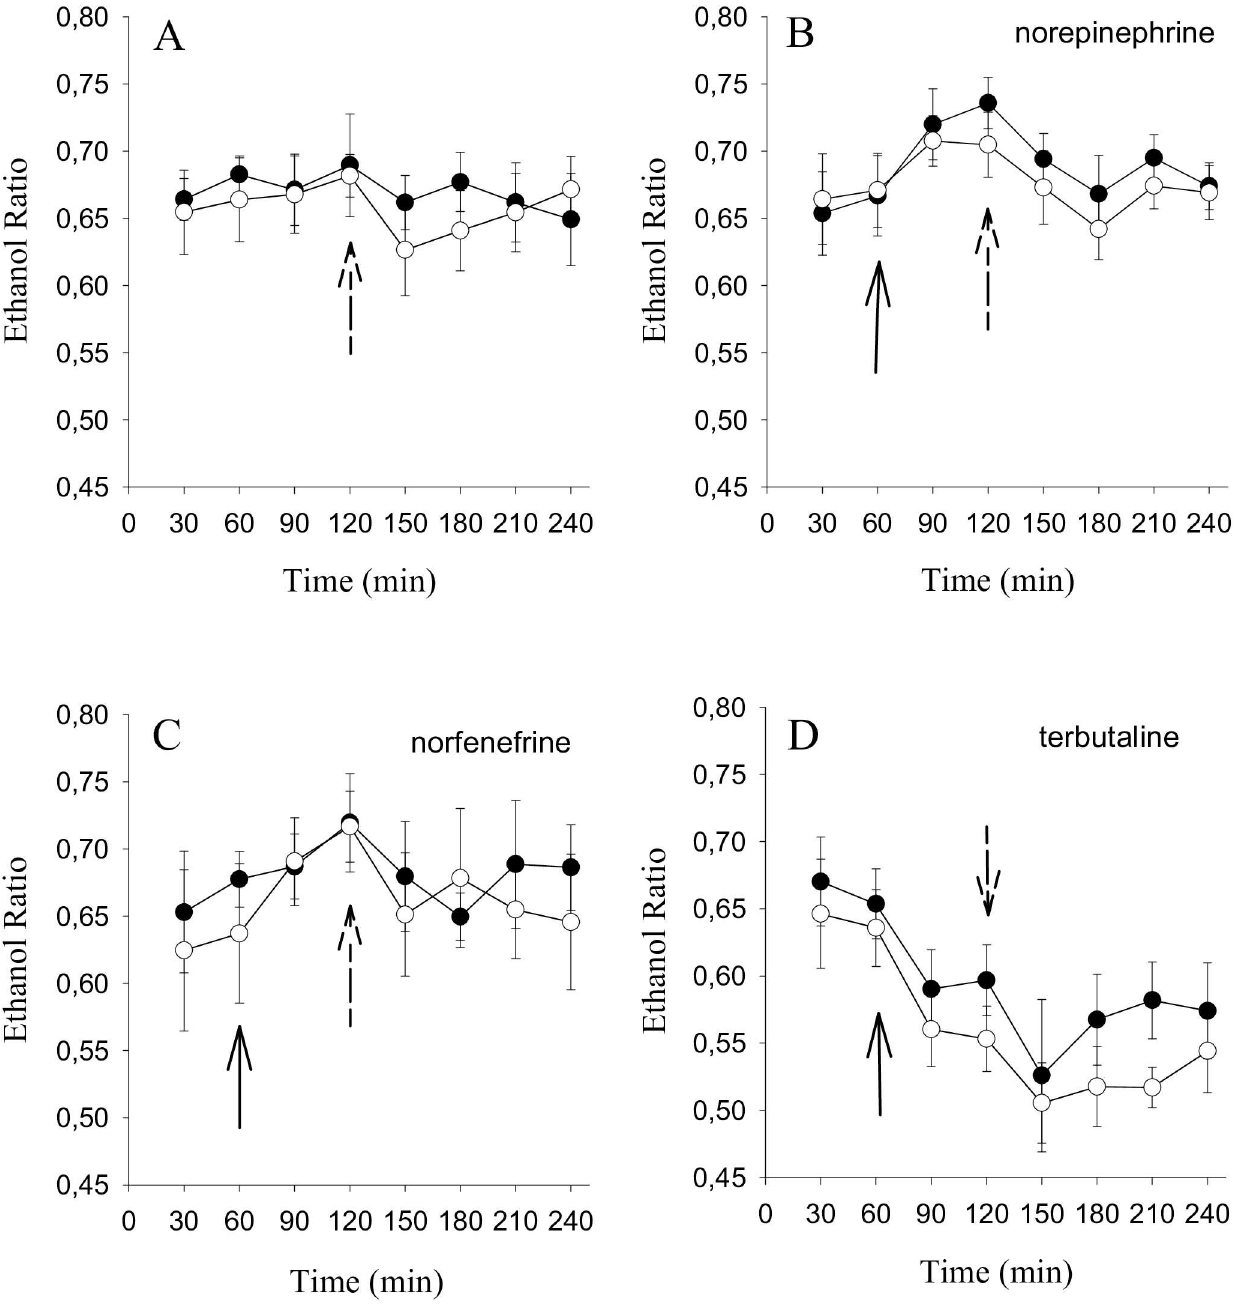
Fig 4. Change in adipose tissue blood flow in response to adrenergicstimulation and after an iv-glucose load. Ethanolratio representing bloodflow in the abdominalsubcutaneous adiposetissue of 14 obeseT2D subjects(•) and 14 obesecontrols ( (cid:14) ). Fig 4A: Perfusionwith saline duringthe durationof the experimentonly. Perfusionwith salinefor 60 minutesandthereafter administration of norepinephrine(Fig 4B), norfenefrine (Fig 4C) or terbutaline (Fig 4D), respectively, at a concentration of 10 − 4 M each (solid arrow). 120minutesafter the start of the microdialysis experiments an iv-glucose load was givenintravenously (0.5 g/kg lean body mass) (dottedarrow). Data are means ± SEM.